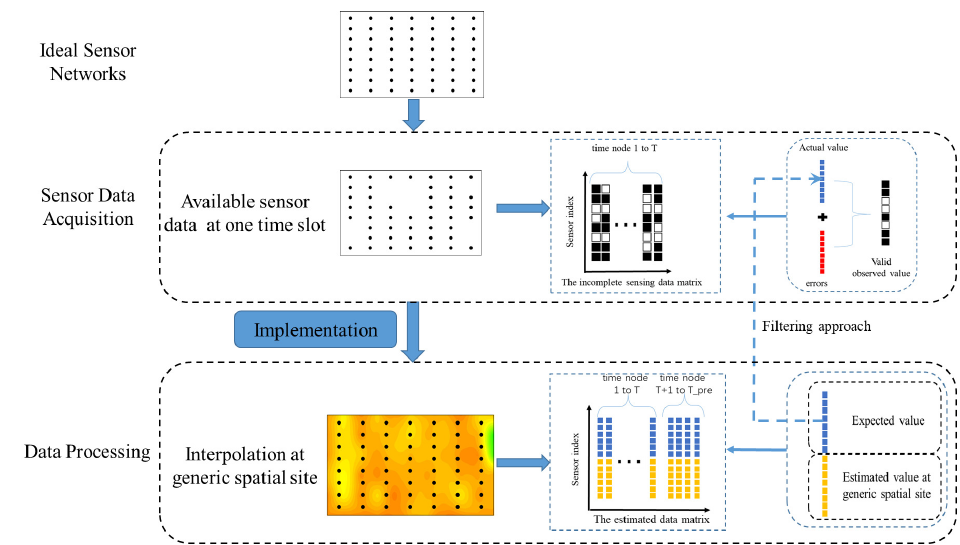
Figure 1. General processing of spatio-temporal